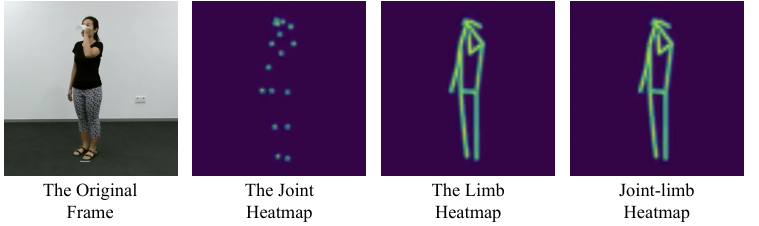
Figure 3. The examples of generated joint heatmap, limb heatmap, and joint–limb heatmap. Video Decomposition. Following [18], we denote a heatmap video as V ∈ R F × H × W × 3